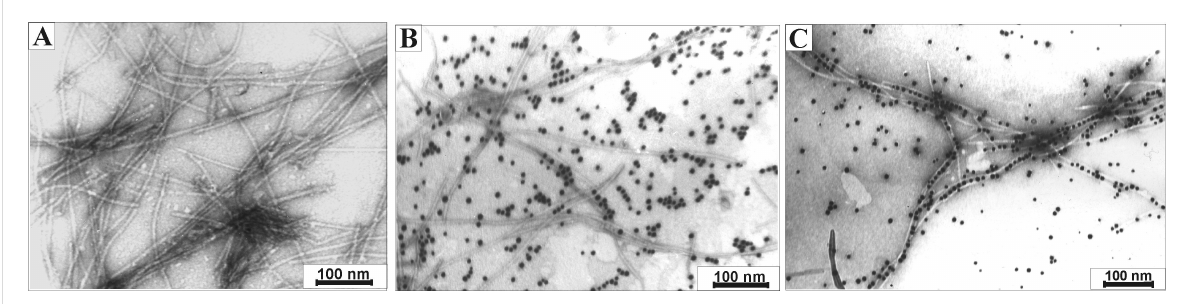
Figure 3: TEM image of modified α -SynC141 fibrils. α -SynC141 fibrils modified with biotin (A). α -SynC141 fibrils modified with biotin and neutravidin- conjugated gold nanoparticles after 24 hours of incubation (B). Modified α -SynC141 fibrils with biotin and neutravidin-conjugated gold nanoparticles after a week of incubation (C). The scale bar indicates 100 nm. The magnification was